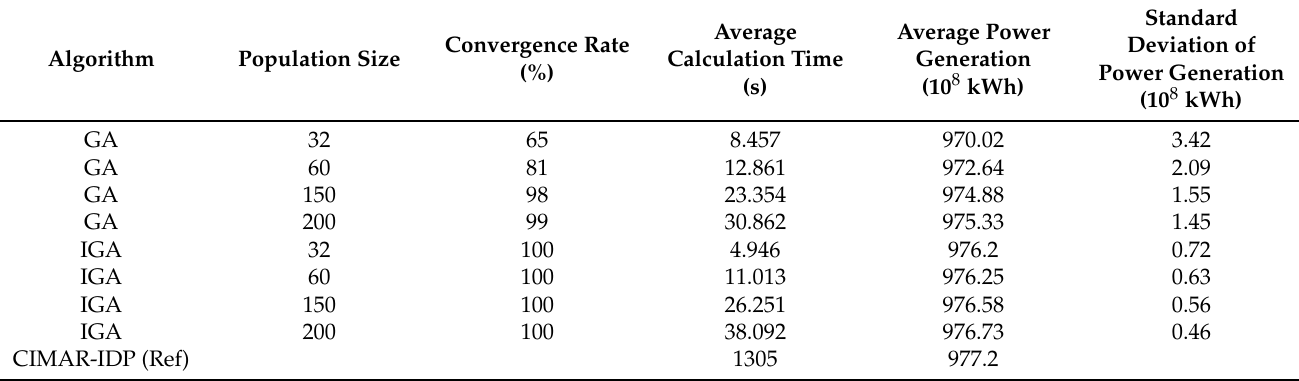
Table 3. Statistics for solutions to optimal scheduling of power generation produced by different